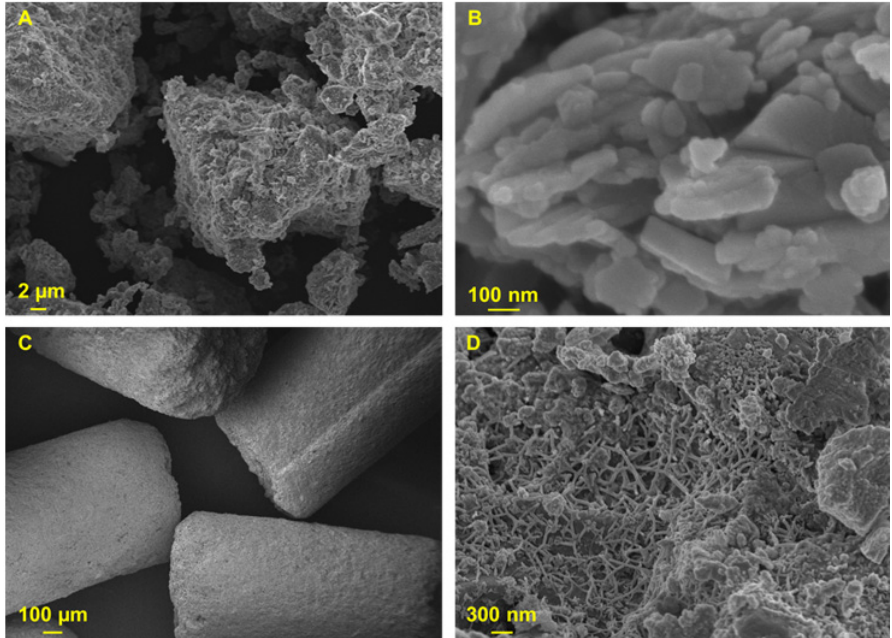
Figure 2. FESEM images of Clin ( A , B ) and AC ( C , D ) at different magnifications.